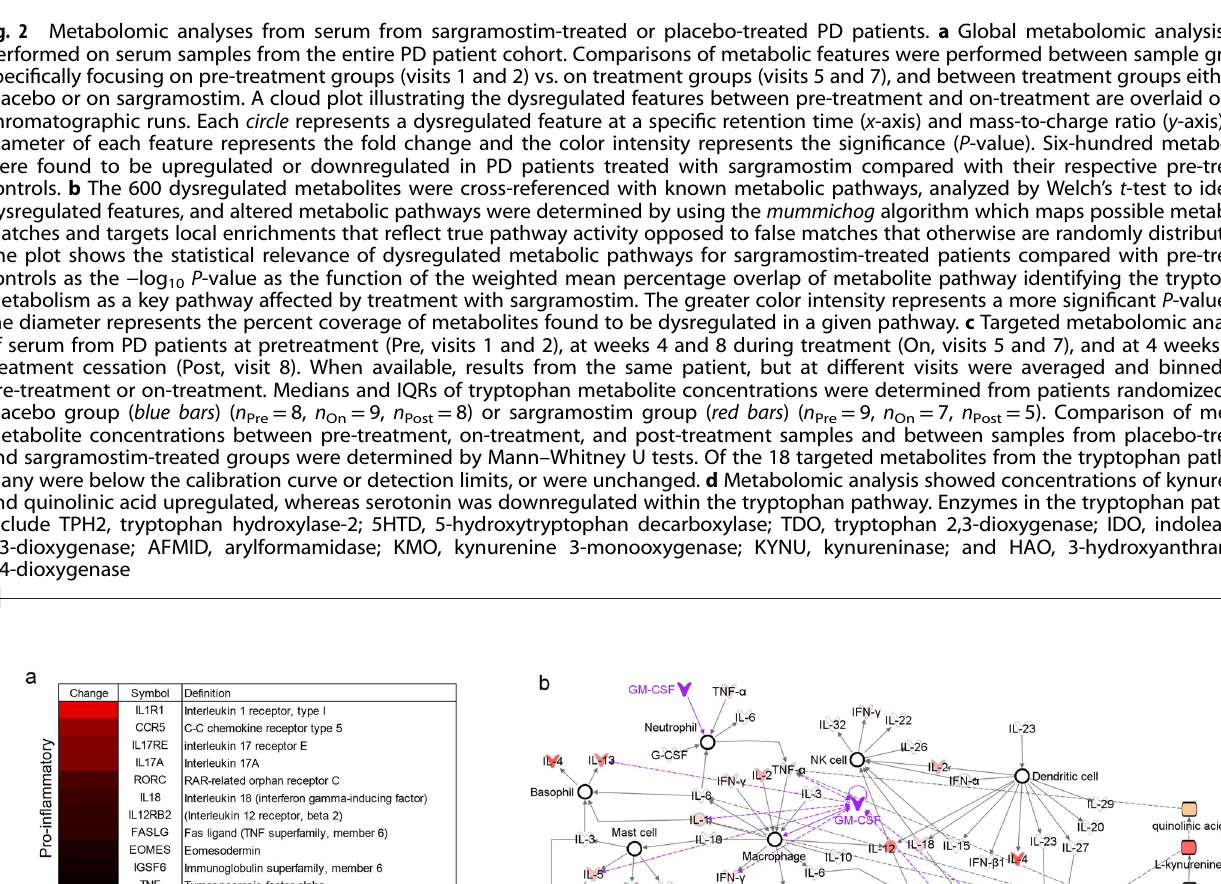
Fig. 2 Metabolomic analyses from serum from sargramostim-treated or placebo-treated PD patients. a Global metabolomic analysis was performed on serum samples from the entire PD patient cohort. Comparisons of metabolic features were performed between sample groups speci fi cally focusing on pre-treatment groups (visits 1 and 2) vs. on treatment groups (visits 5 and 7), and between treatment groups either on placebo or on sargramostim. A cloud plot illustrating the dysregulated features between pre-treatment and on-treatment are overlaid on the chromatographic runs. Each circle represents a dysregulated feature at a speci fi c retention time ( x -axis) and mass-to-charge ratio ( y -axis). The diameter of each feature represents the fold change and the color intensity represents the signi fi cance ( P -value). Six-hundred metabolites were found to be upregulated or downregulated in PD patients treated with sargramostim compared with their respective pre-treated controls. b The 600 dysregulated metabolites were cross-referenced with known metabolic pathways, analyzed by Welch ’ s t -test to identify dysregulated features, and altered metabolic pathways were determined by using the mummichog algorithm which maps possible metabolite matches and targets local enrichments that re fl ect true pathway activity opposed to false matches that otherwise are randomly distributed. 16 The plot shows the statistical relevance of dysregulated metabolic pathways for sargramostim-treated patients compared with pre-treated controls as the − log 10 P -value as the function of the weighted mean percentage overlap of metabolite pathway identifying the tryptophan metabolism as a key pathway affected by treatment with sargramostim. The greater color intensity represents a more signi fi cant P -value and the diameter represents the percent coverage of metabolites found to be dysregulated in a given pathway. c Targeted metabolomic analyses